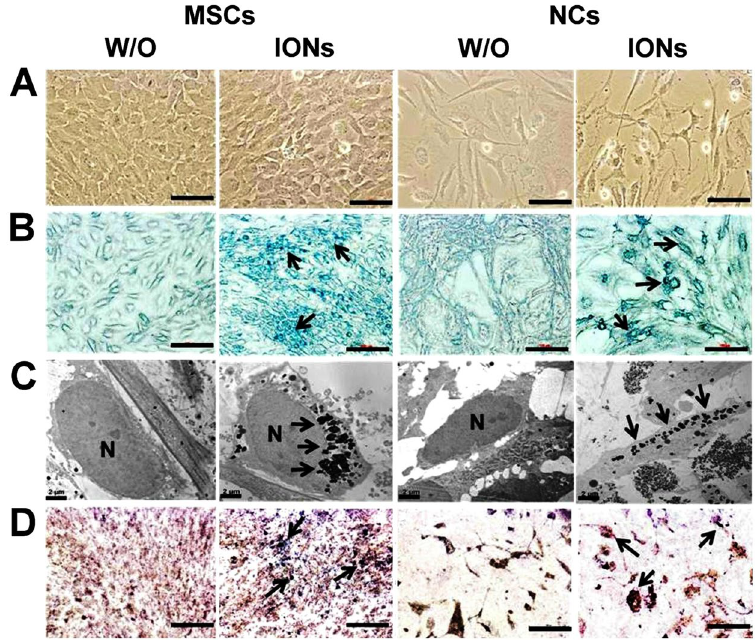
Figure 1. Comparison of hMSCs differentiation capacity into NCs with or without (w/o) ION. Light microscopic image ( A ), Prussian blue staining ( B ), TEM image ( C ) and co-staining with PTAH and Prussian blue ( D ). The blue and black dots indicated by black arrows are ingested